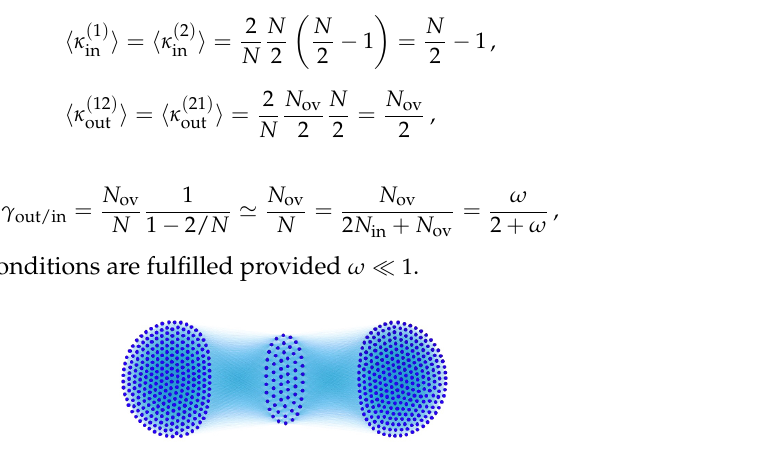
Figure 6. A network with two overlapping cliques, N = 600 and N ov =